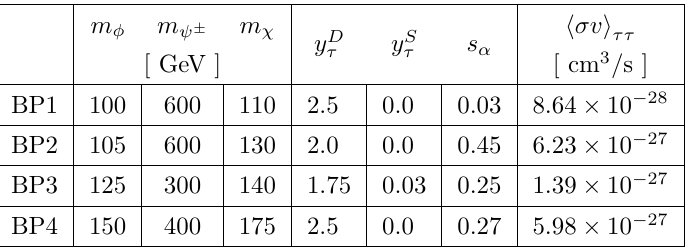
Table 5 . Relic density allowed benchmark points which are below the Fermi-LAT limit. Around m φ ∼ 100 GeV, the Fermi-LAT bound is ∼ 10 − 26 cm 3